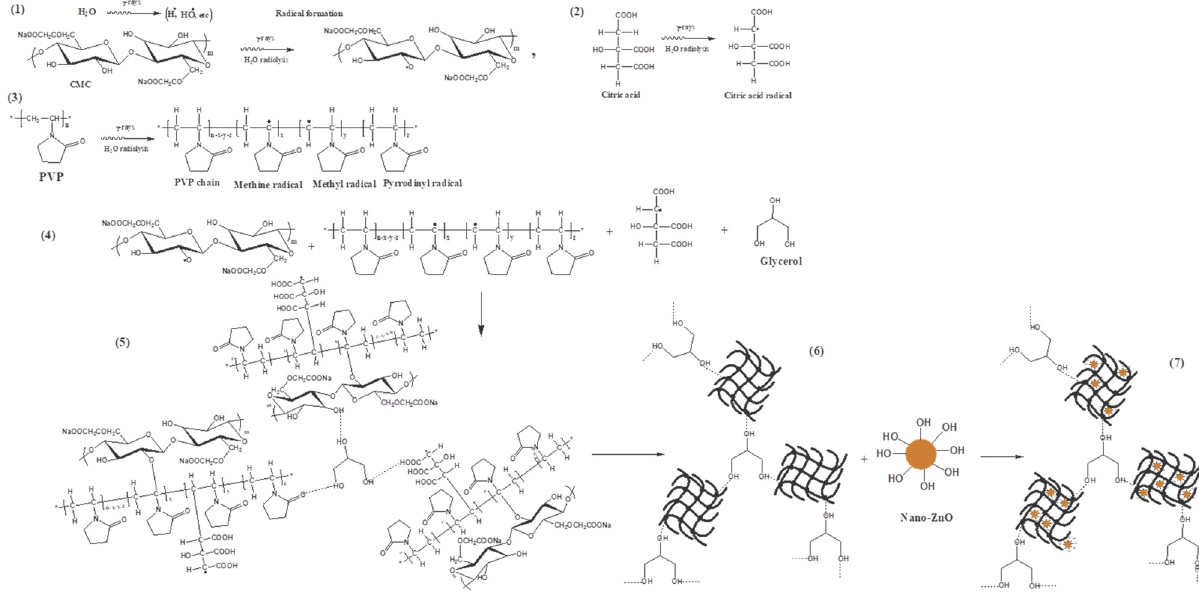
Figure 1: A suggested reactions mechanisms of ( PVP:CMC ) /CA/G crosslinked fi lm formation and ( PVP:CMC ) /CA/G/ZnO nano fi